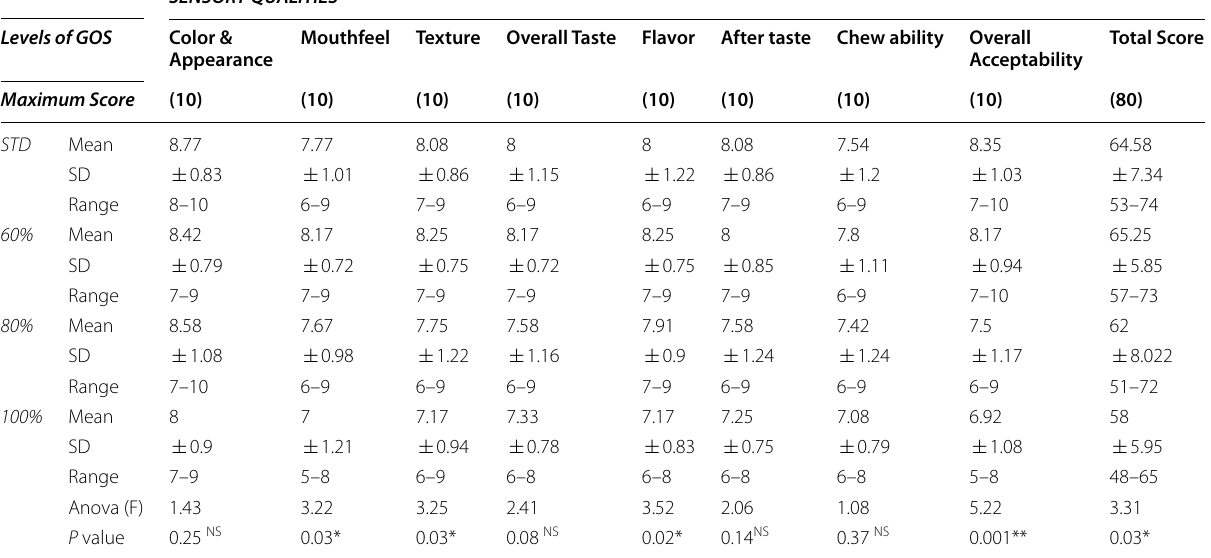
Table 5 Standardization with varying levels of GOS addition